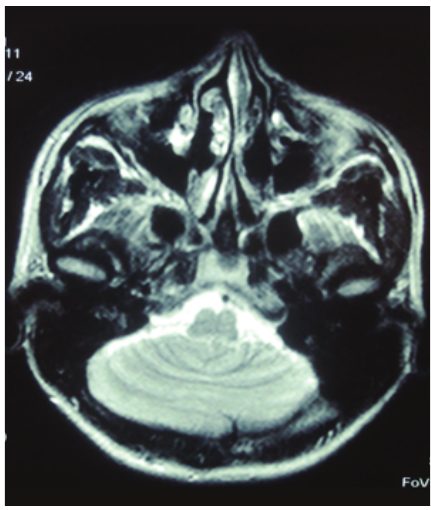
Figure1:Magneticresonanceimagingofbrainwhichdemonstrated partially developed vermis and